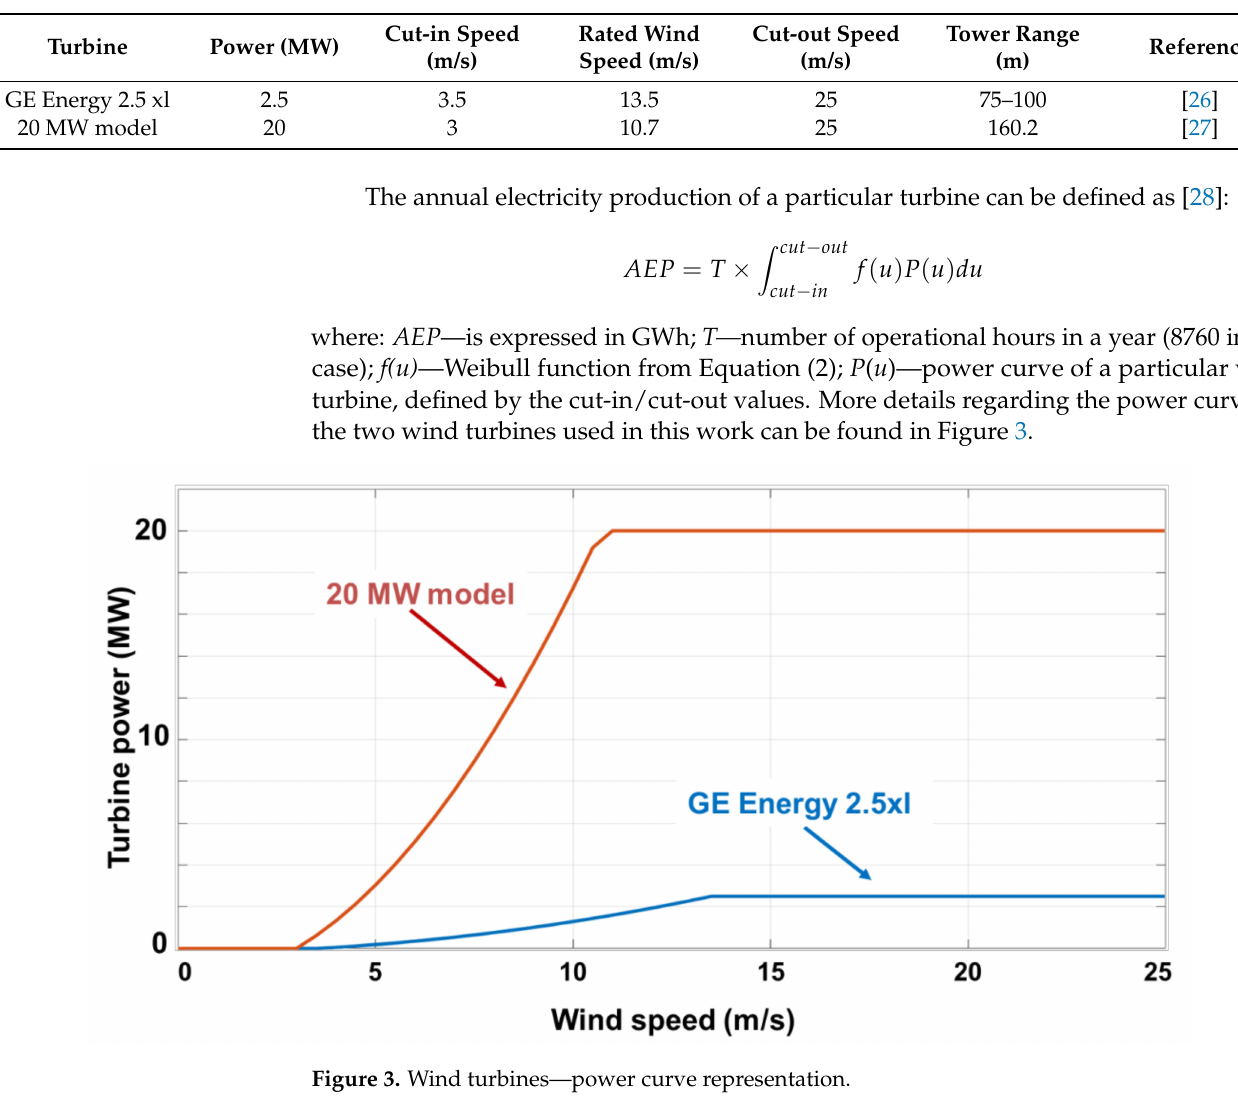
Table 4. Characteristics of the wind turbines considered in the present work.